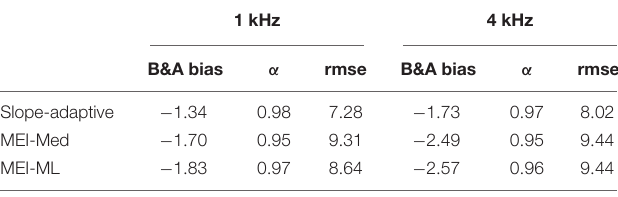
TABLE 6 | Accuracy was assessed by comparing the three adaptive procedures to the Fixed-Level procedure across both visits. 1 kHz 4